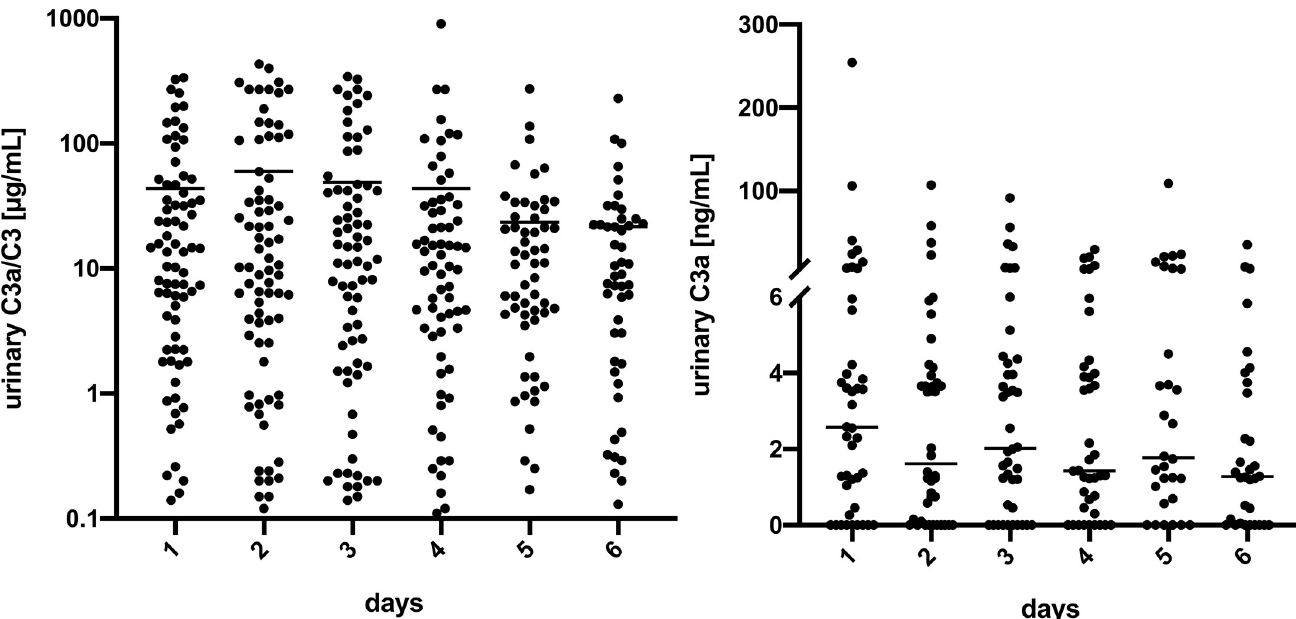
Fig 2. ELISA-measurement of urinary complement factor C3a/C3 and C3a in 85 ICU patients. Data are presented in columned scatter graphs; the horizontal lines mark the mean values of the respective C3a/C3 (left) and C3a (right) levels. Day 1: n = 78; day 2: n = 78; day 3: n = 72; day 4: n = 66; day 5: n = 56; day 6: n = 48.